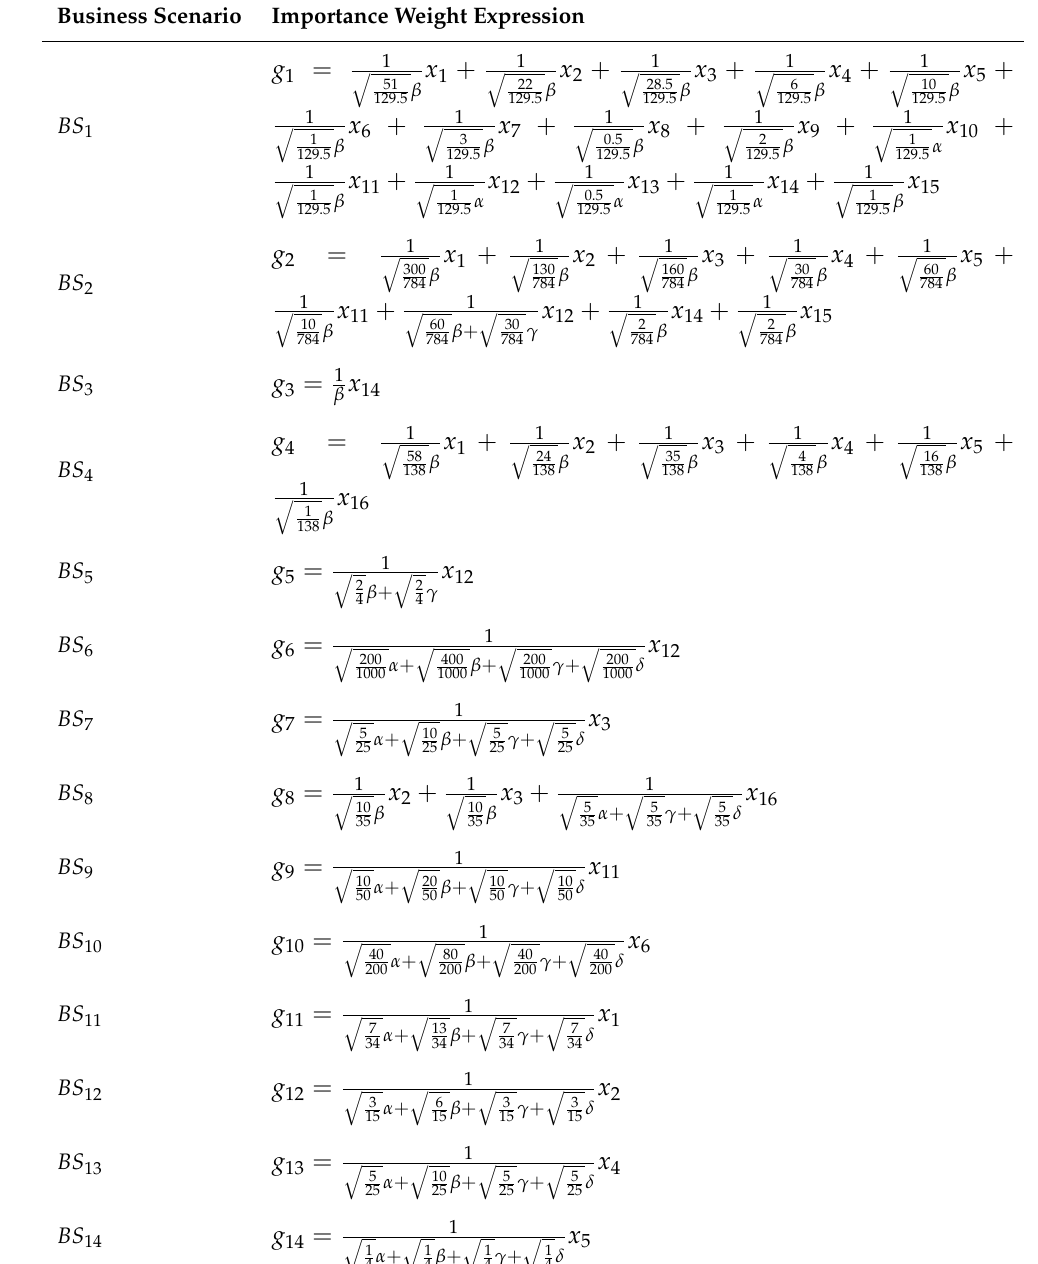
Table A21. Business scenarios’ importance weights represented by the database contribution x of the DBCAMS